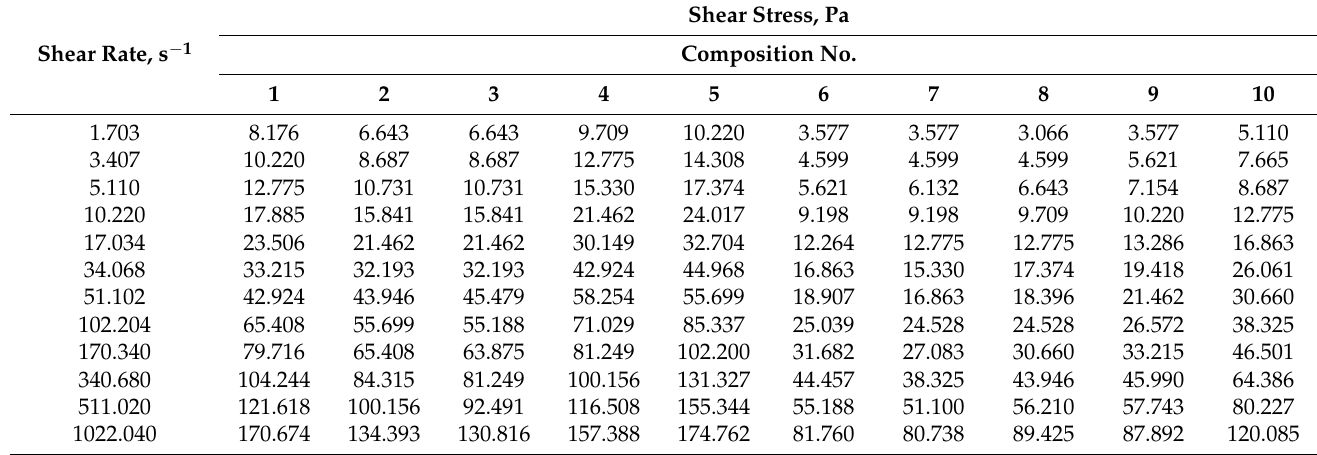
Table 7. Results of measurements and calculated values of shear stress for slurries.